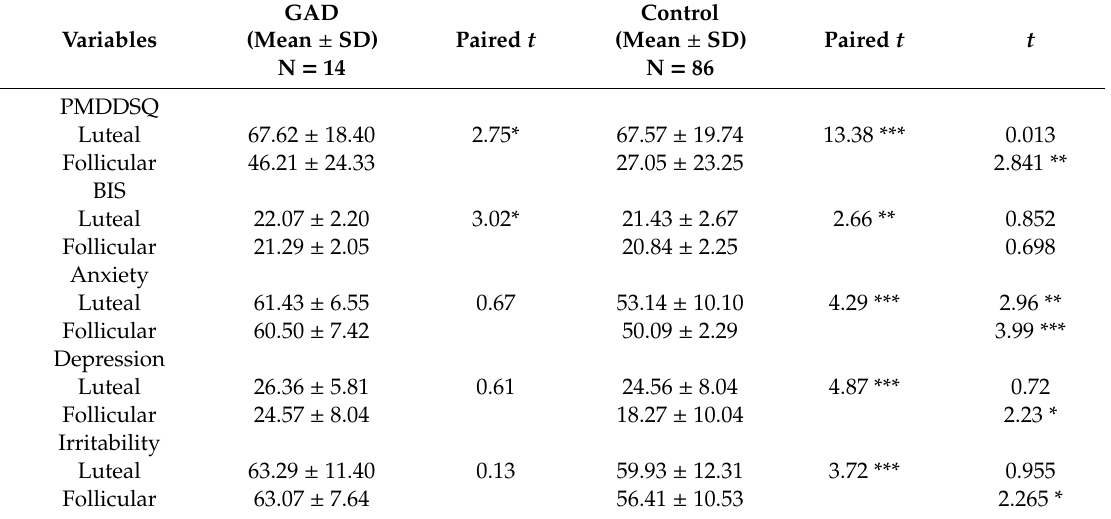
Table 3. Di ff erence in premenstrual dysphoric disorder (PMDD) symptom severity, behavior inhibition system (BIS), anxiety, depression, and irritability between women with generalized anxiety disorder and those without, among women with